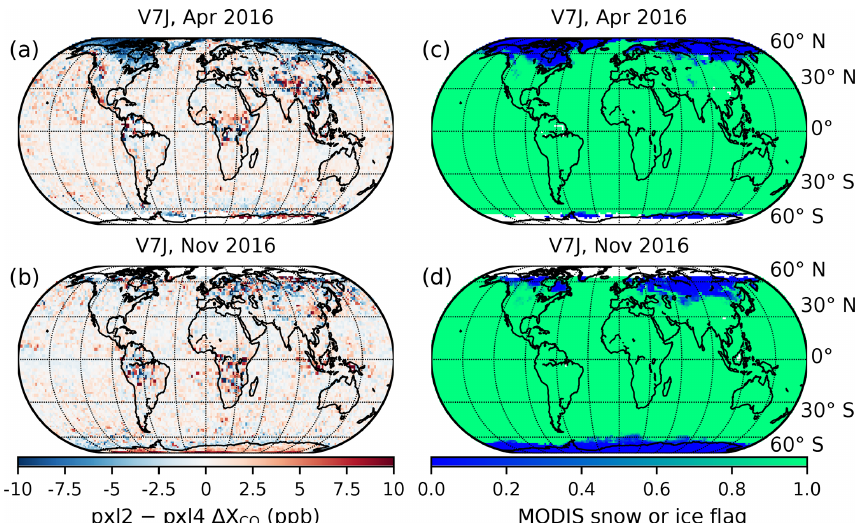
Figure 1. On the left (a, b) are average differences in X CO between pixels 2 and 4. On the right (c, d) is the corresponding MODIS snow or ice flag, where 0 indicates all snow or ice and 1 indicates that the scenes were clear of snow or ice. Some correlation is observed between bins with a large pixel-to-pixel bias and snow or ice cover. Here and throughout we use an Eckert IV equal-area projection.